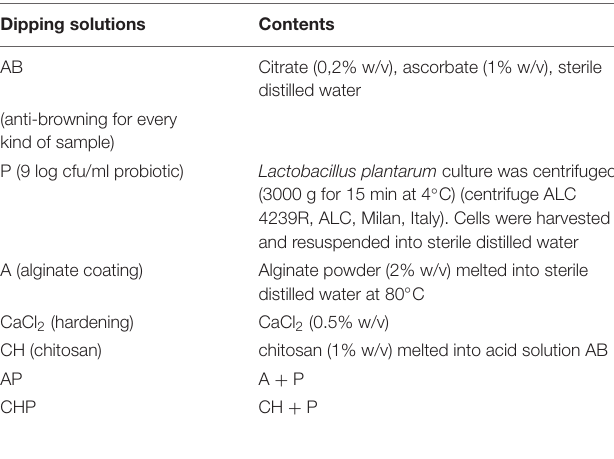
TABLE 1 | Dipping solutions.